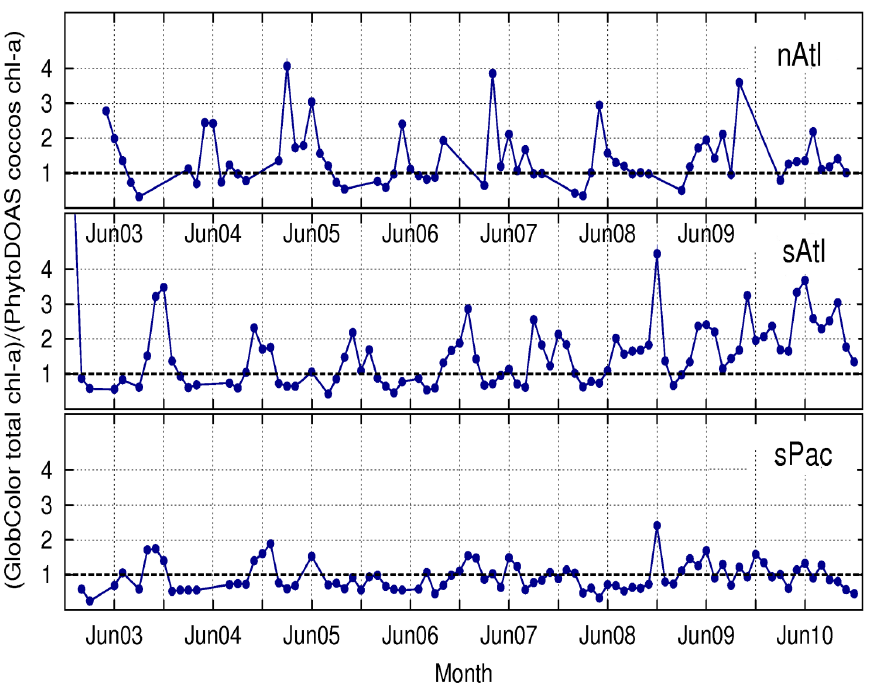
Fig. 7. Ratios of the GlobColour total chl-a to the PhytoDOAS retrieved chl-a of coccolithophores in three selected regions: nAtl (upper panel), sAtl (middle panel) and sPac (lower panel).